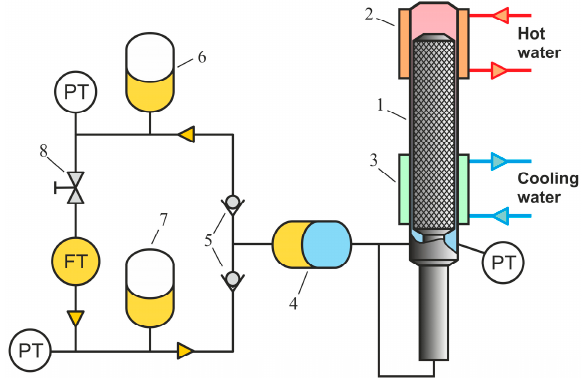
Figure 5. Scheme of the experimental setup. 1 —IE engine, 2 —heating jacket, 3 —cooling jacket, 4 —diaphragm unit, 5 —non-return valves, 6 —high-pressure accumulator, 7 —low-pressure accumulator, 8 —throttle valve, PT —pressure transmitters, FT —flow transmitter.